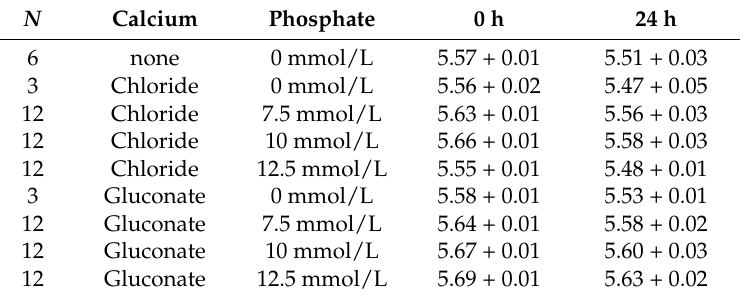
Table 3. Mean and Standard Deviation for pH of solutions compounded with Premasol ( N = number of bags).